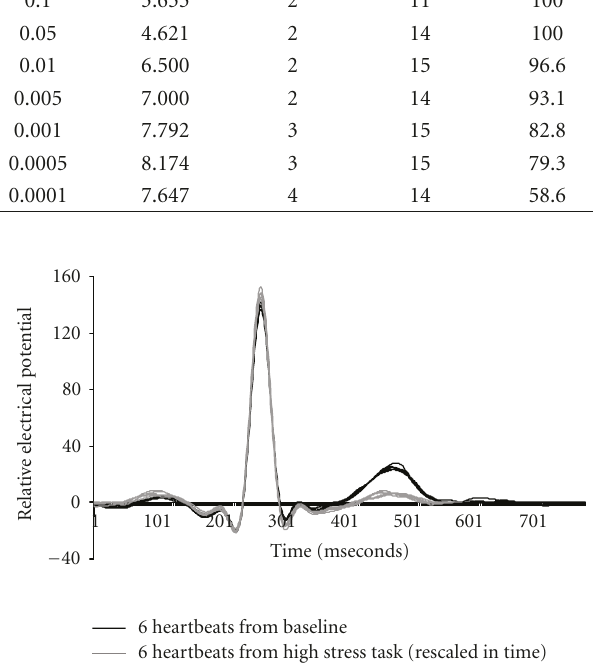
Figure 12: Aligned heartbeats from high stress and low stress